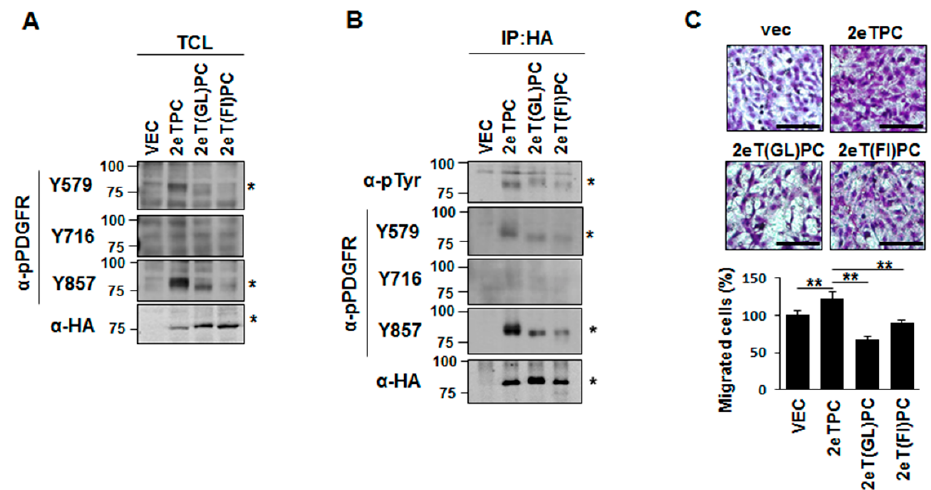
Figure 6. The dimerization induced by the transmembrane specifically regulates the signaling events mediated by Tyr 579 phosphorylation. ( A ) NIH3T3 cells were transfected with vec, 2eTPC, 2eT(GL)PC, and 2eT(FI)PC chimeras. Tyrosine phosphorylation in total cell lysates was determined by Western blotting analysis using phosphorylation-specific antibodies against p-PDGFR Y579, Y716, and Y857. ( B ) Total cell lysates were immunoprecipitated with an anti-HA antibody and subjected to Western blotting with phosphorylation site-specific antibodies. Migration positions of SDS-resistant monomers (*) are indicated ( C ) Transwell migration assays were performed using 10% FBS as a chemoattractant in the lower chamber. Cells were allowed to migrate for 18 h and stained with 0.6% hematoxylin and 0.5% eosin (top). Scale bar = 100 µ m. The migrated cells were counted (bottom). The data shown are representative of three independent experiments. Bars represent average ± standard deviation; ** p < 0.001.